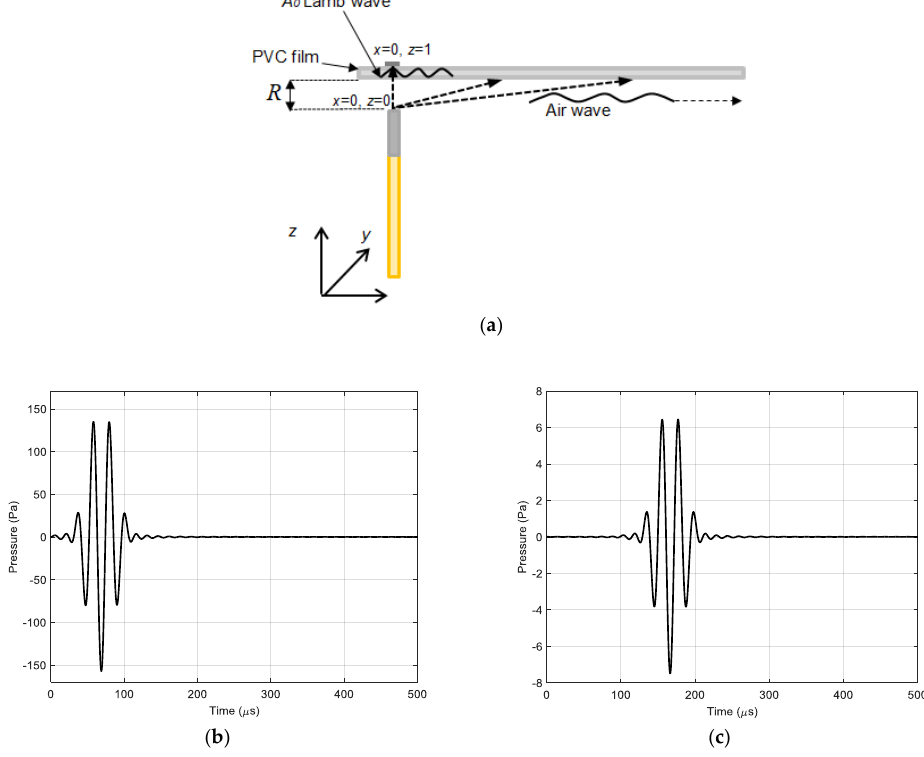
Figure 7. Calculated waveforms of the incident ultrasonic pressure pulses in the plane of the plastic film (z = 1 mm) at different distances from the piezo element symmetry axis: ( a ) schematic diagram showing propagation directions of ultrasonic pulses; ( b ) x = 0 mm (piezo element centre); and ( c ) x = 35